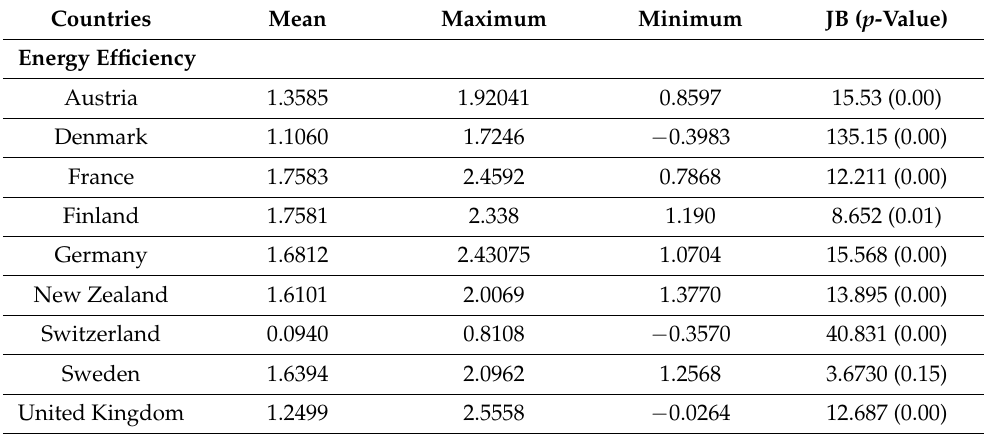
Table 1. Descriptive